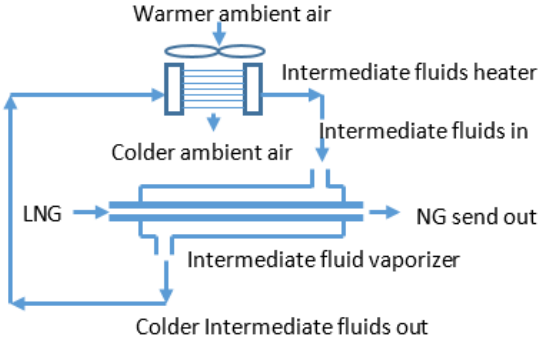
Figure 7. Intermediate fluid vaporizer (air IFV).